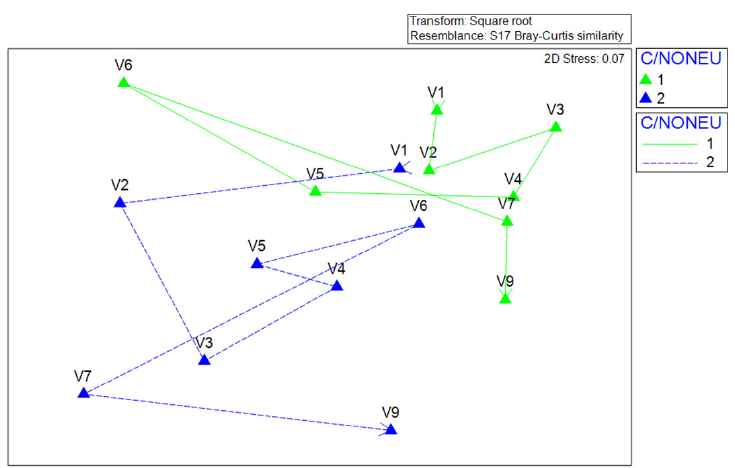
Figure 9. Non-metric multidimensional scaling (NMDS) ordination based on Bray–Curtis similarity distance in the taxonomic composition of phytoplankton community on sampling stations (V1 to V9, excluding station V8) in Lake Visovac during August 2018 according to the molecular eDNA approach. 1-C- composite samples, 2-NONEU-aphotic zone samples.